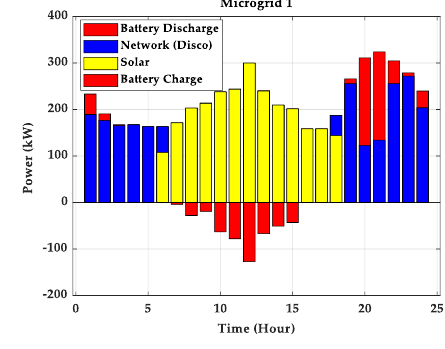
Figure 16. Impact of demand response on Microgrid 1.